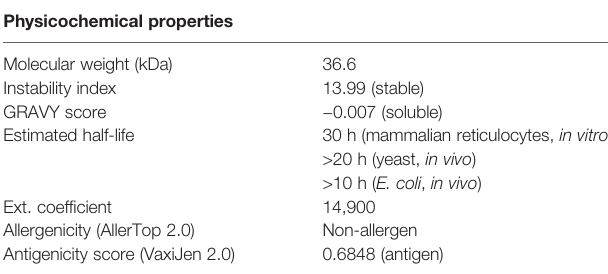
TABLE 2 | Physicochemical features of the chimeric vaccine